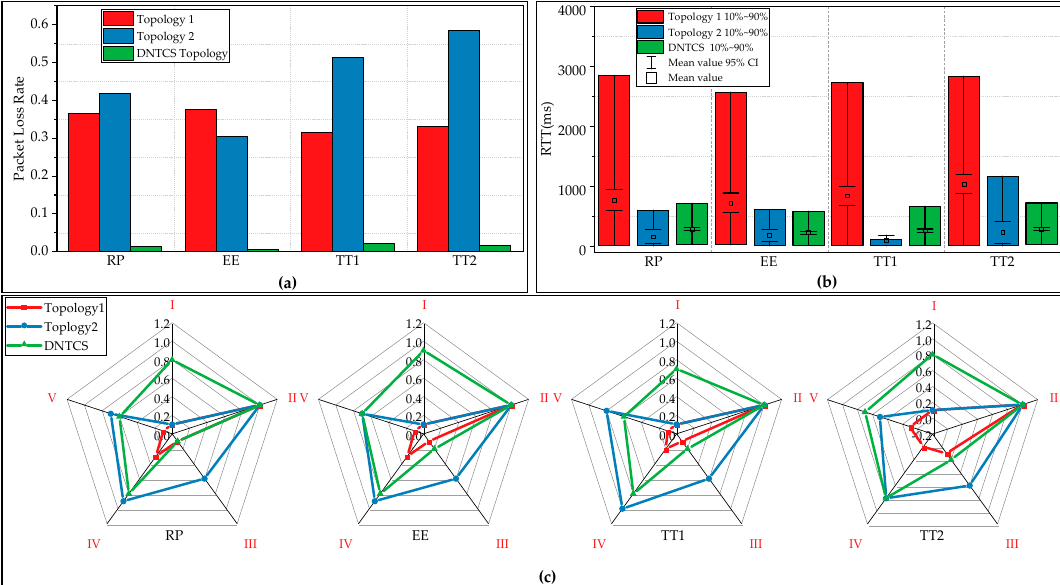
Figure 20. Results for Scenario 3.2 regarding the network performances of the mobile nodes. ( a ) Packet loss rate; ( b ) RTT; ( c ) normalized performance metrics.